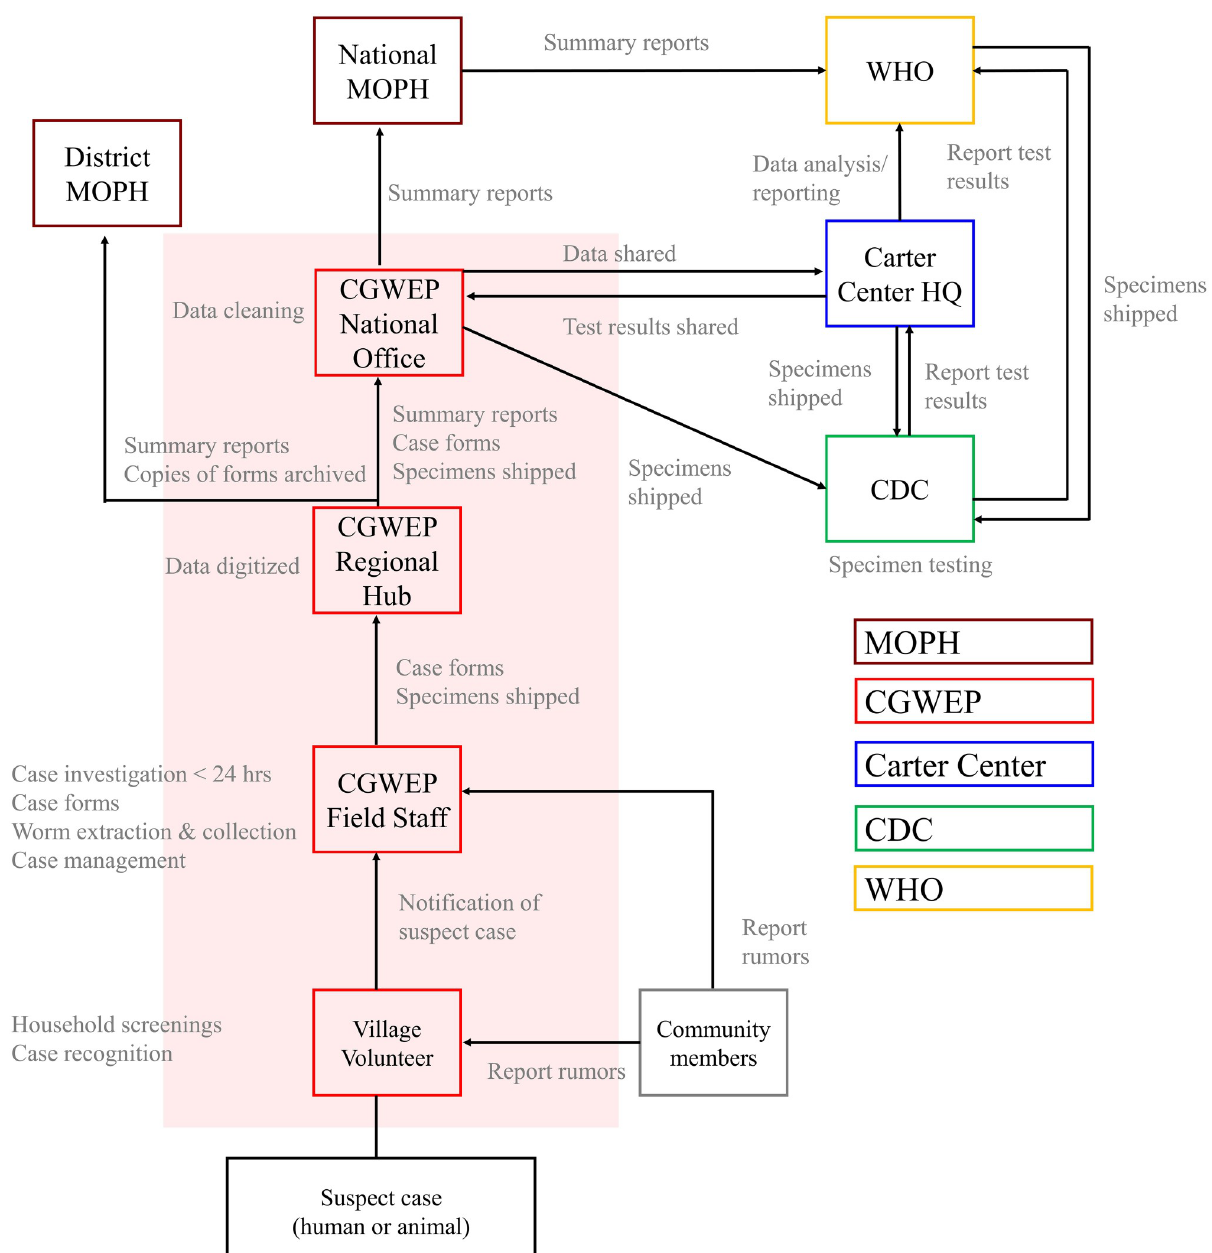
Fig 1. Chad Guinea Worm Eradication Program surveillance system (CGWEP). The active surveillance system (Levels 1 and 2) is summarized by the figure above. The CGWEP (red boxes and red shaded area) is housed within the Chad Ministry of Public Health (MOPH) (maroon boxes).